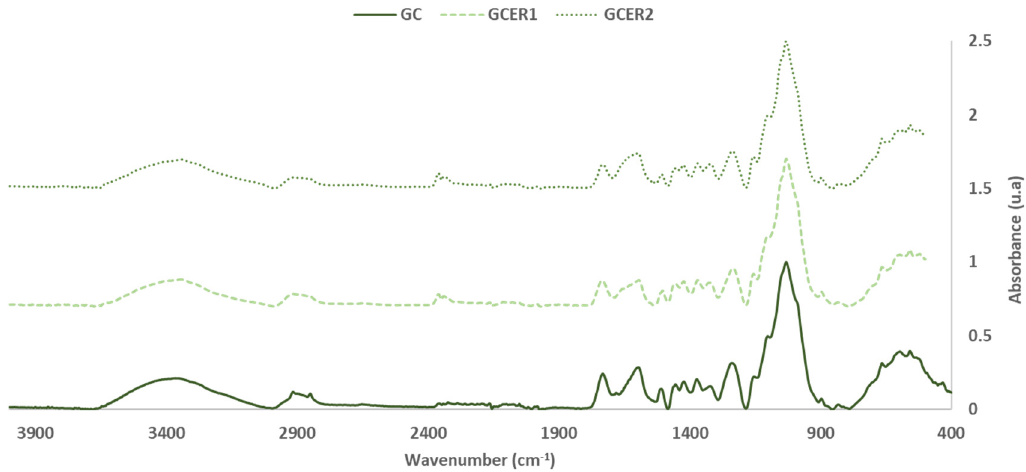
Figure 1. FTIR spectra: Solid grape canes before (GC) and after (GC ER1 , GC ER2 ) the extraction process (400–4000 cm − 1 ).